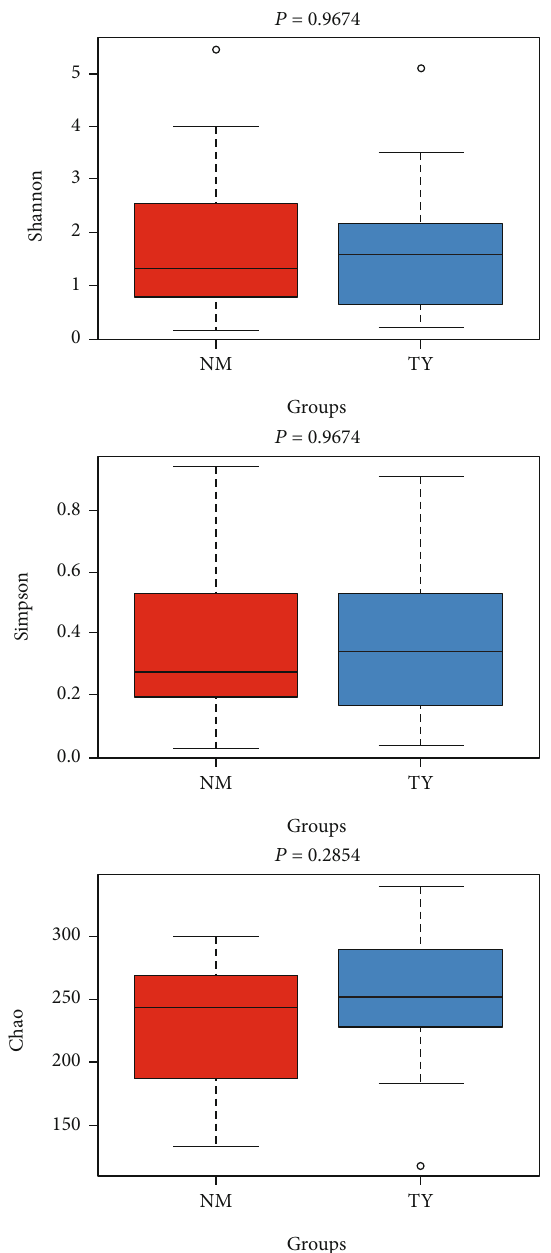
Figure 4: Alpha diversity index and rarefaction curve. Shannon, Simpson, Chao index in embryonic death group and control group. The box plots represent diversity measures and the central line represents the median